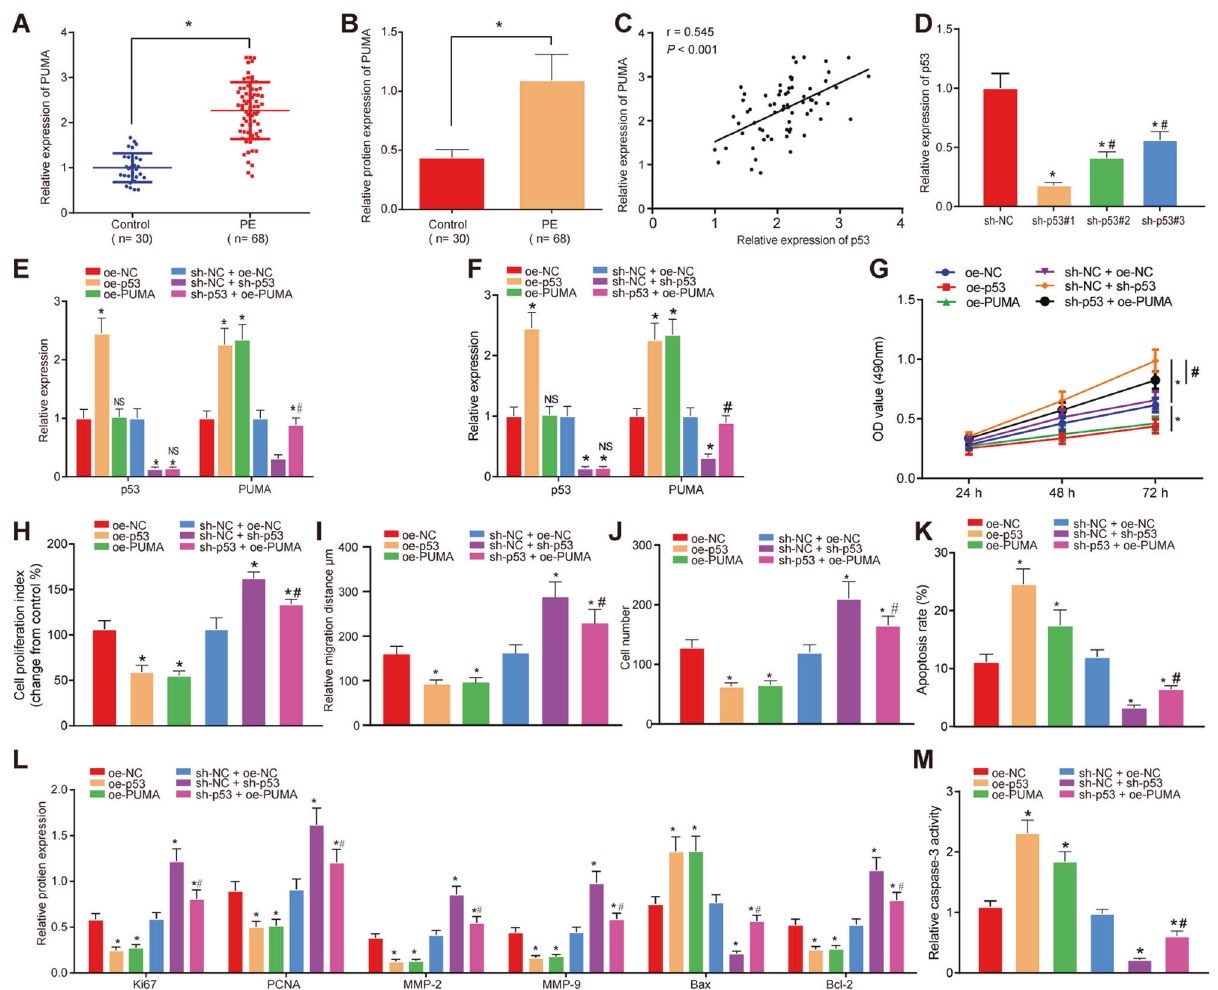
Fig. 4 p53 upregulates PUMA expression to accelerate cell proliferation, invasion, and migration, but reduce apoptosis of HTR8/SVneo cells. A RT-qPCR detection on mRNA expression of PUMA (control n = 30, PE n = 68). B Western blot analysis on protein expression of PUMA (control n = 30, PE n = 68). C Correlation between p53 and PUMA expression analyzed by Pearson ’ s correlation coef fi cient. D RT-qPCR detection on knockdown ef fi ciency of p53 in HTR8/SVneo cells. E mRNA expression of p53 and PUMA in each group of transfected HTR8/ SVneo cells by RT-qPCR 48 h after transfection. F Protein expression of p53 and PUMA in each group of transfected HTR8/SVneo cells at 24 th , 48 th , and 72 nd hour after transfection by western blot. G HTR8/SVneo cell viability 48 h after transfection evaluated by MTT assay. H HTR8/ SVneo cell proliferation 48 h after transfection evaluated by BrdU assay. I Migrating ability of HTR8/SVneo cells 24 h after transfection examined using scratch assay. J HTR8/SVneo cell invasion 24 h after transfection assessed using transwell assay. K HTR8/SVneo cell apoptosis in each group analyzed by fl ow cytometry 48 h after transfection. L Protein expression of Ki67, PCNA, MMP-2, MMP-9, Bax, and Bcl-2 in HTR8/ SVneo cells 48 h after transfection studied by western blot. M Caspase-3 activity in HTR8/SVneo cells 48 h after transfection. * p < 0.05 vs. oe-NC or sh-NC + oe-NC; # p < 0.05 vs. sh-NC + sh-p53. The quantitative data were presented as mean ± standard deviation. Difference between two groups was analyzed using paired t- test. Data among multiple groups were processed using one-way ANOVA followed with Tukey ’ s post hoc test. Cell experiments were repeated 3